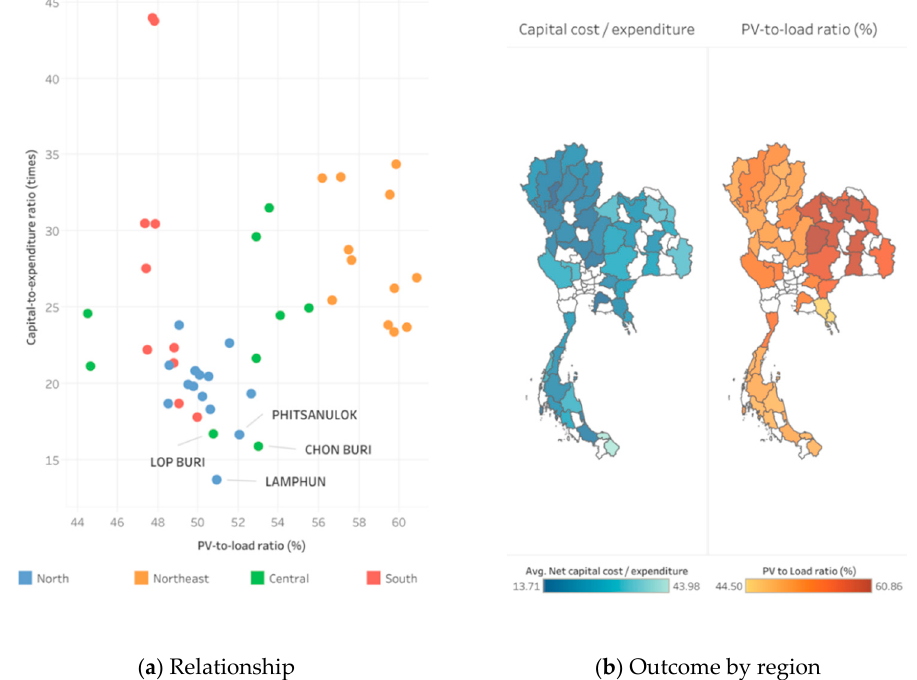
Figure 12. Residential customer investment hotspots (under a net-billing compensation scheme with a 1 THB/kWh buyback rate).